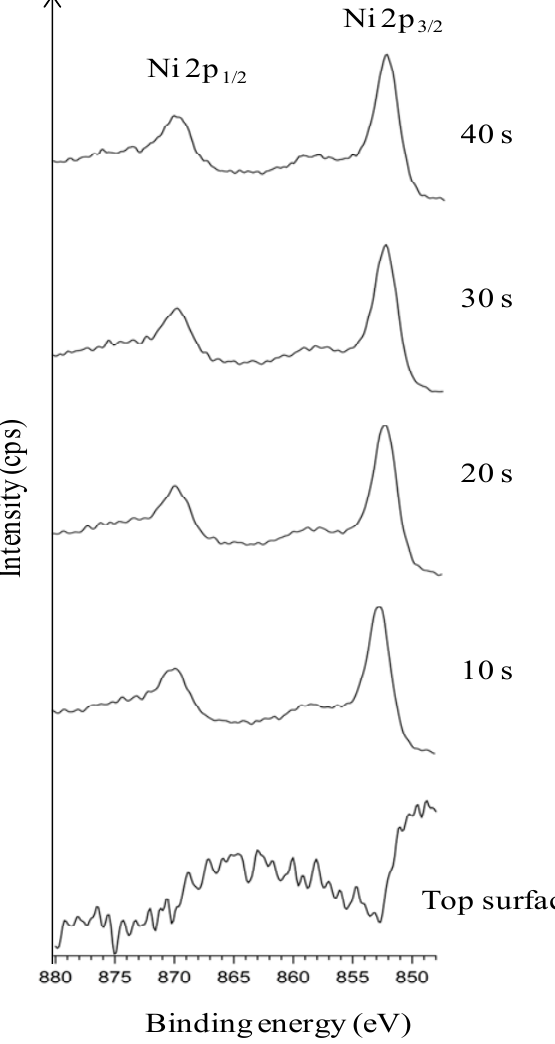
Figure 2. XPS depth profile studies of Ni peaks in uncleaned